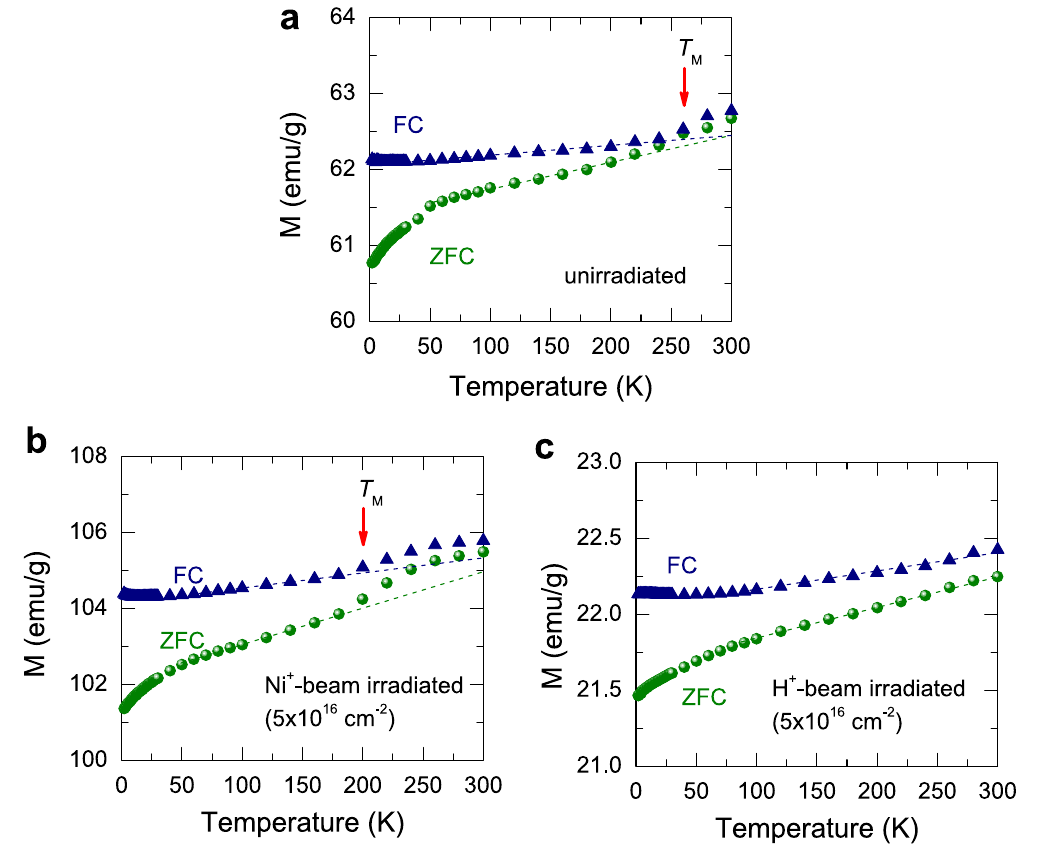
Figure 4. ZFC-FC magnetization curves of ( a ) unirradiated, ( b ) Ni + -beam-irradiated, and ( c ) H + -beam- irradiated CI powders measured with an applied magnetic field of 500 Oe. The dashed lines denote a linear behavior of the magnetization as a guide to the